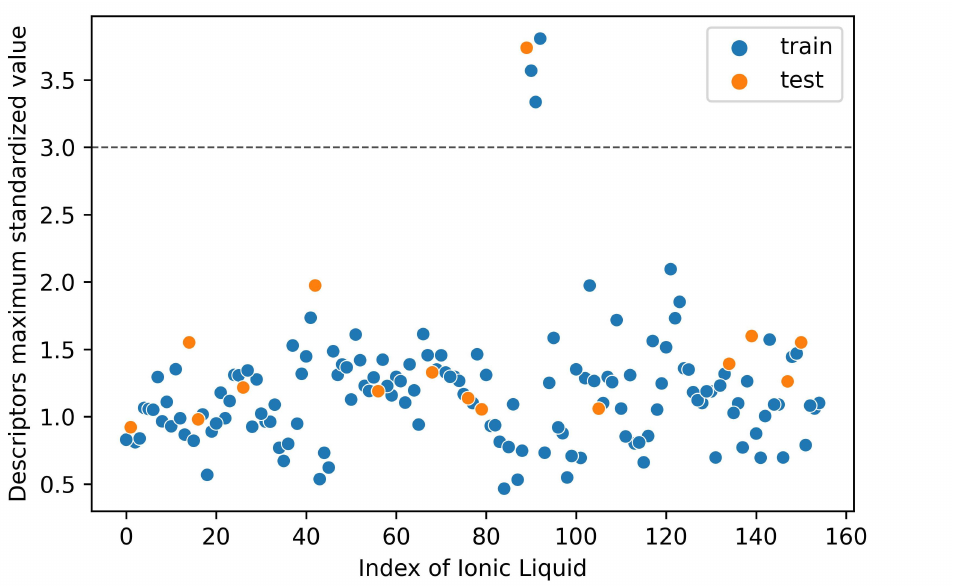
Figure 7. Applicability domain defined in this study. One ionic liquid in the test set is outside the AD, and three ILs in the training set are outliers as their corresponding descriptors’ maximum standardized values are greater than the 3.0